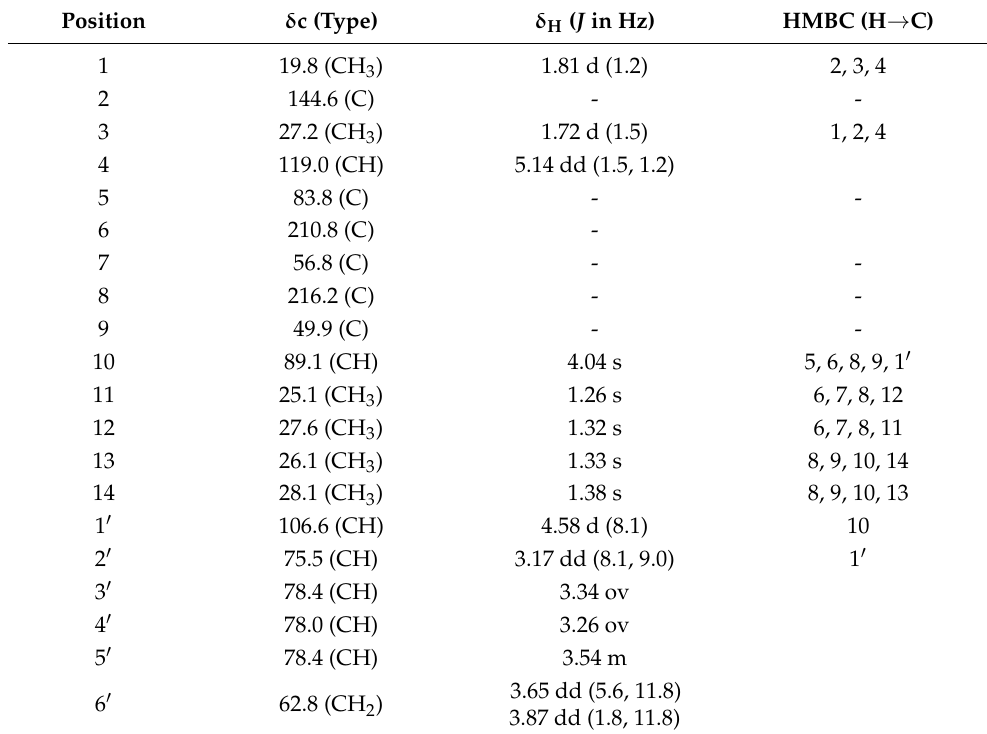
Table 2. NMR data of compound 4 in CD 3 OD 1